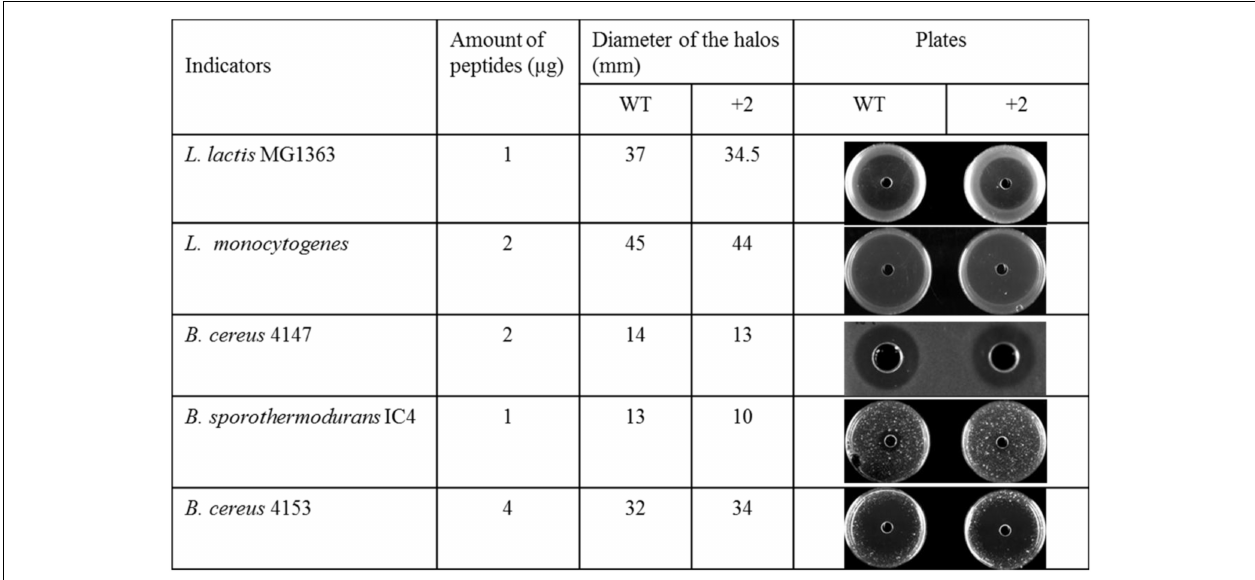
FIGURE 3 | Activity of nisin and + 2 variant in solid media at low